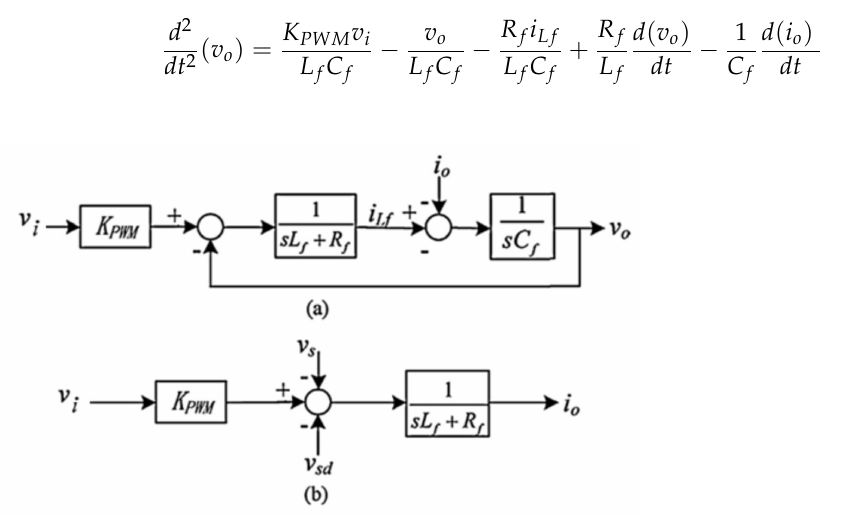
Figure 4. The equivalent circuits of a DG; ( a ) grid-connected mode, ( b ) islanding mode. Which is compatible with the diagram represented in Figure 4a.